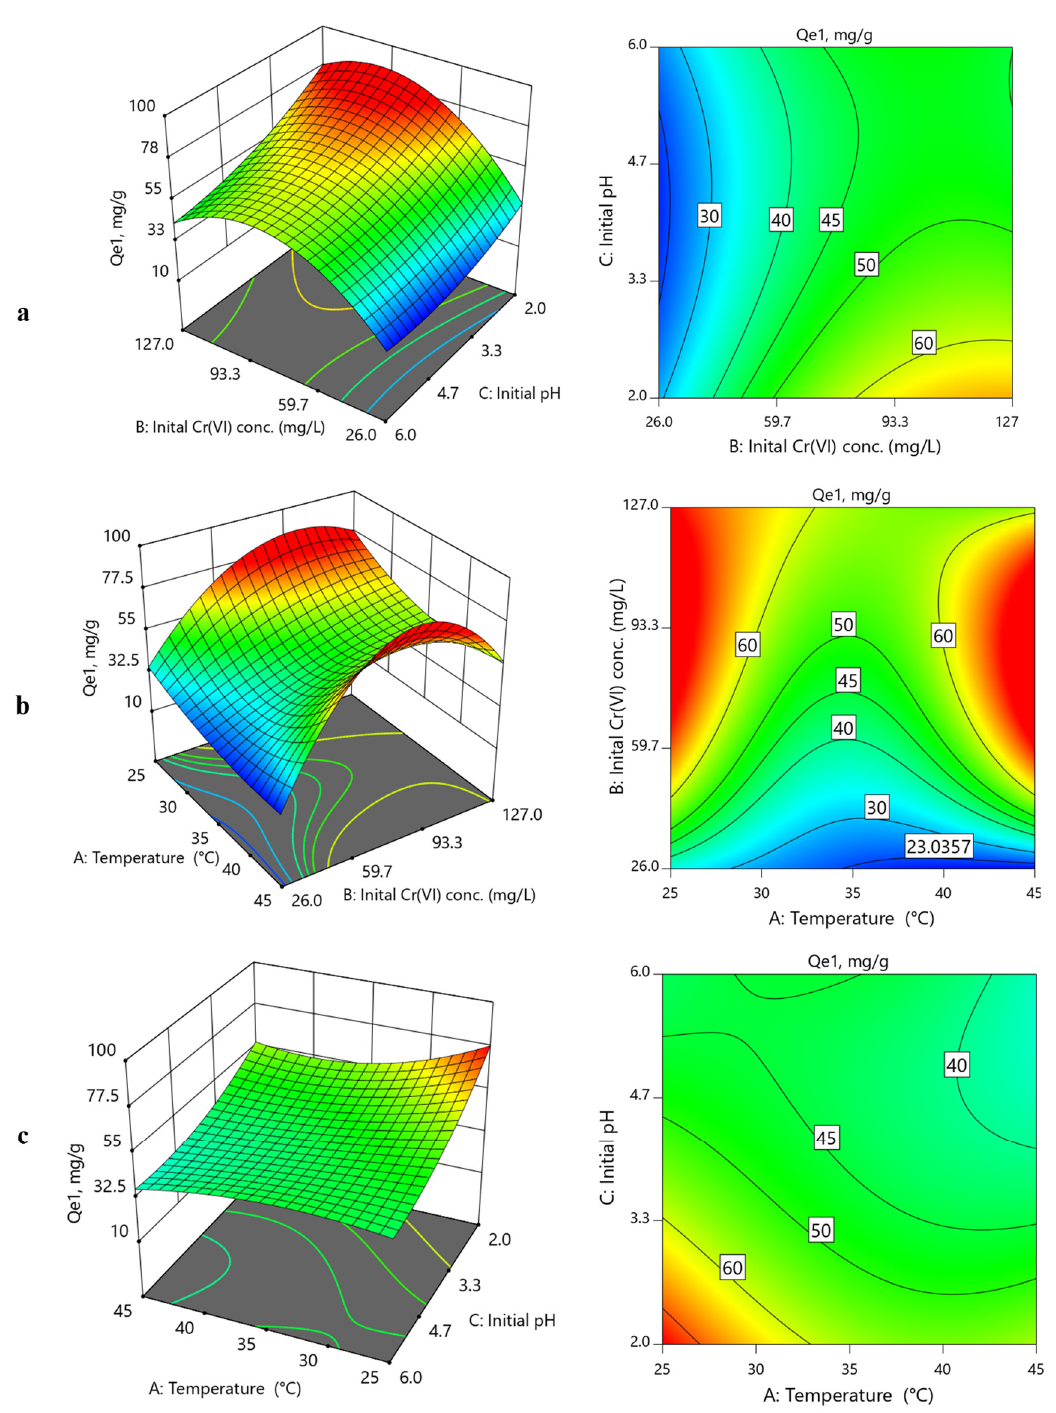
Figure 6. 3D and 2D contour plots for binary influence of ( a ) initial Cr(VI) concentration vs. initial pH; ( b ) temperature vs. initial Cr(VI) concentration; ( c ) initial pH vs. temperature on CoAl-LDH uptake capacity (Qe1) for Cr(VI) removal from water.